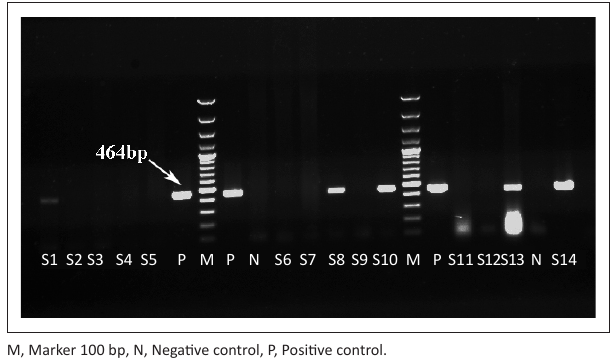
M, Marker 100 bp, N, Negative control, P, Positive control. S1 and S8, trachea; S2 and S9, lungs; S3 and S10, caecal tonsils; S4 and S11, kidney; S5 and S12, spleen; S13, bursa of Fabricius; S6, thymus; S7 and S14, cloaca. FIGURE 6: Detection of infectious bronchitis virus by Reverse transcription polymerase chain reaction in different tissue samples.